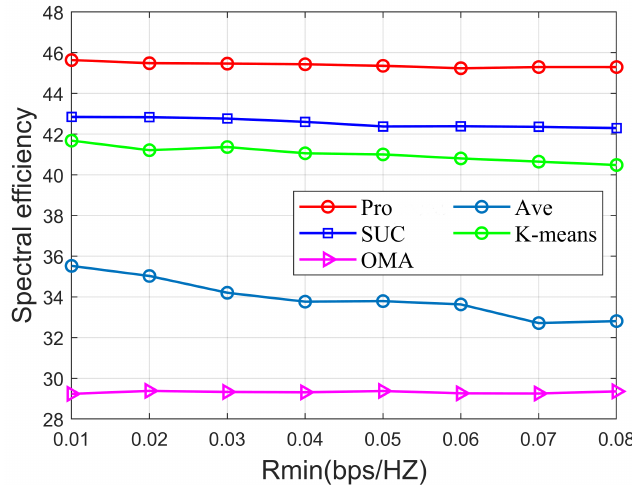
Figure 8. SE versus R min of different